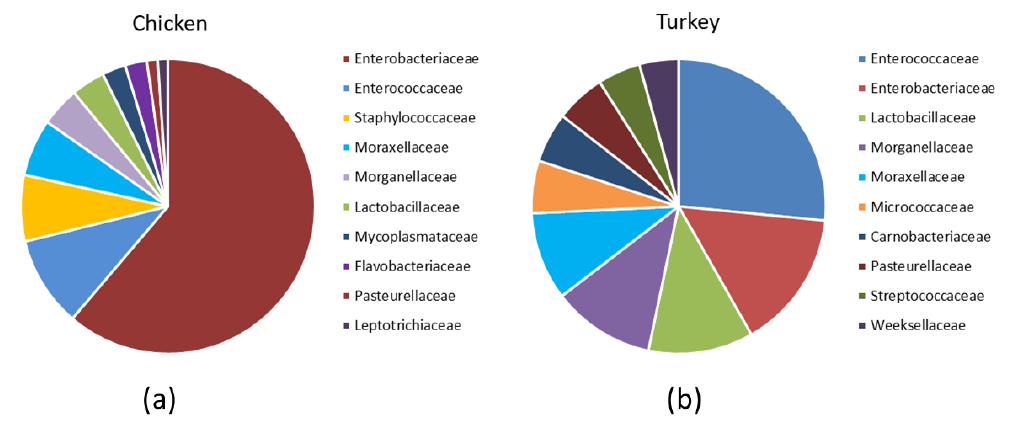
Figure 2. Relative abundance of the 10 most prevalent families among the URT bacteria in ( a ) chickens and ( b ) turkeys.